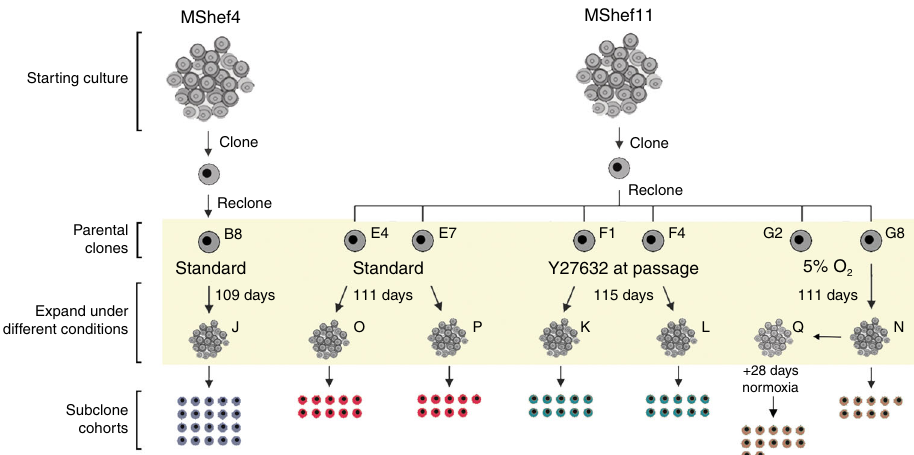
Fig. 1 Schematic representation of the experimental design. Schematic representation of the experimental regime, in which MShef4 and MShef11 human ES cell lines were cultured for an extended period under different growth-conditions. Stock cultures of MShef4 and MShef11 were cloned by single-cell deposition to ensure a homogeneous starting point. A clone of each was then recloned to generate Parent Clones that were then cultured under the different growth-conditions for a period exceeding three months — MShef4 clone B8, standard conditions, 109 days (19 passages); MShef11 clones E4 & E7, standard conditions, 111 days (25 passages); MShef11 clones F1 & F4, standard conditions + Y27632, 115 days, (25 passages); MShef11 clone G8 low oxygen, 111 days (25 passages) to give subclone cohort N, and 111 days + 28 days in standard oxygen (25 + 6 passages) to give subclone cohort Q. At the end of the expansion period cultures were recloned again into standard conditions to obtain subclone cohorts (J, O, P, K, L, N and Q, respectively, as shown), from which genetic material was extracted as early as possible (5 passages) for sequencing